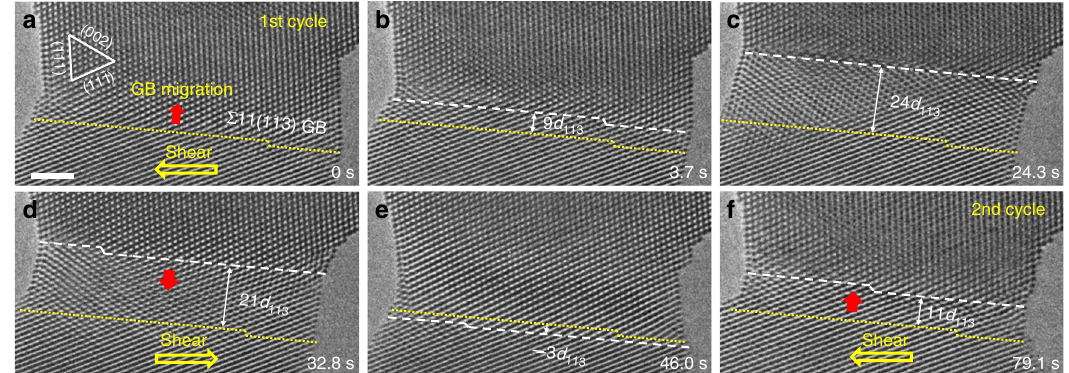
Fig. 4 Reversible GB migration in shear loading cycle. a – c Upward migration of the Σ 11(113) coherent GB under the leftward shear stress (shown by the yellow arrow) in the fi rst loading cycle. A maximum migration distance of 24 d 113 was obtained before the loading was reversed. d , e Downward migration of the Σ 11(113) coherent GB under the rightward shear stress. The GB migrated downward gradually with a total distance of 27 d 113 . f The second shear loading cycle where the leftward shear stress induced an upward GB migration for 11 d 113. The yellow dotted lines and white dashed lines represent the initial and current positions of the GB in each snapshot, respectively. Scale bar: 2